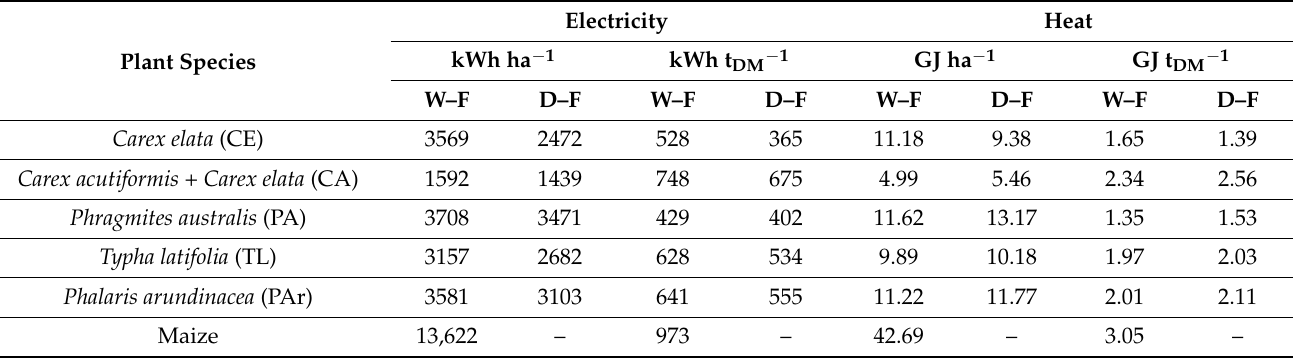
Table 4. Energy generation from anaerobic digestion of wetland plants from natural low-productivity habitats calculated on the basis of the BMP results and measured yields.